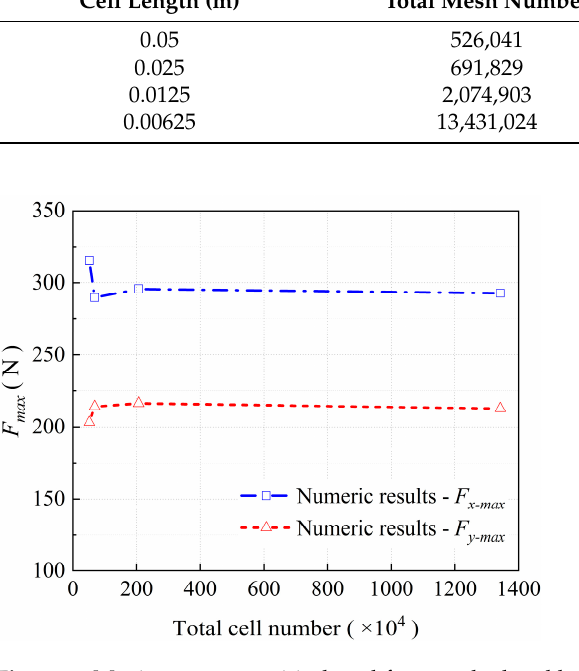
Figure 3. Maximum tsunami-induced forces calculated by the present model with di ff erent mesh sizes in the main calculation domain.